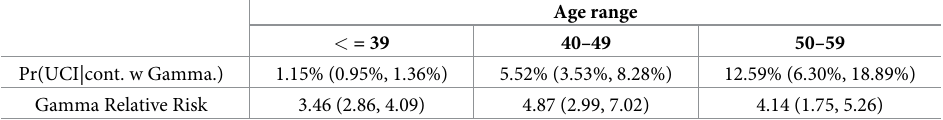
Table 5. Alternative relative risk estimates (and confidence intervals) for ICU admission conditional to infection by age for the Gamma variant—Computed using age-dependent time-windows, minimizing mean square